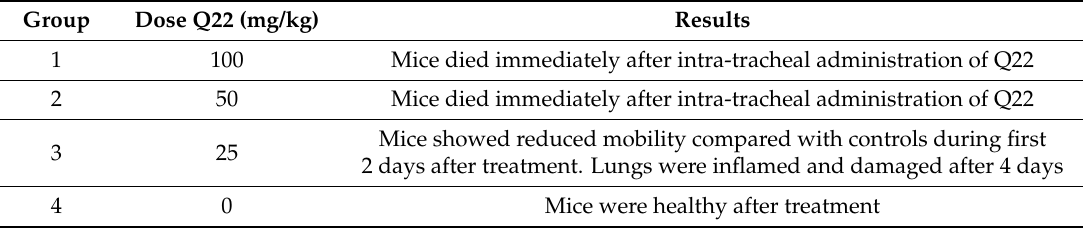
Table 3. Toxicity of Q22 in the mouse